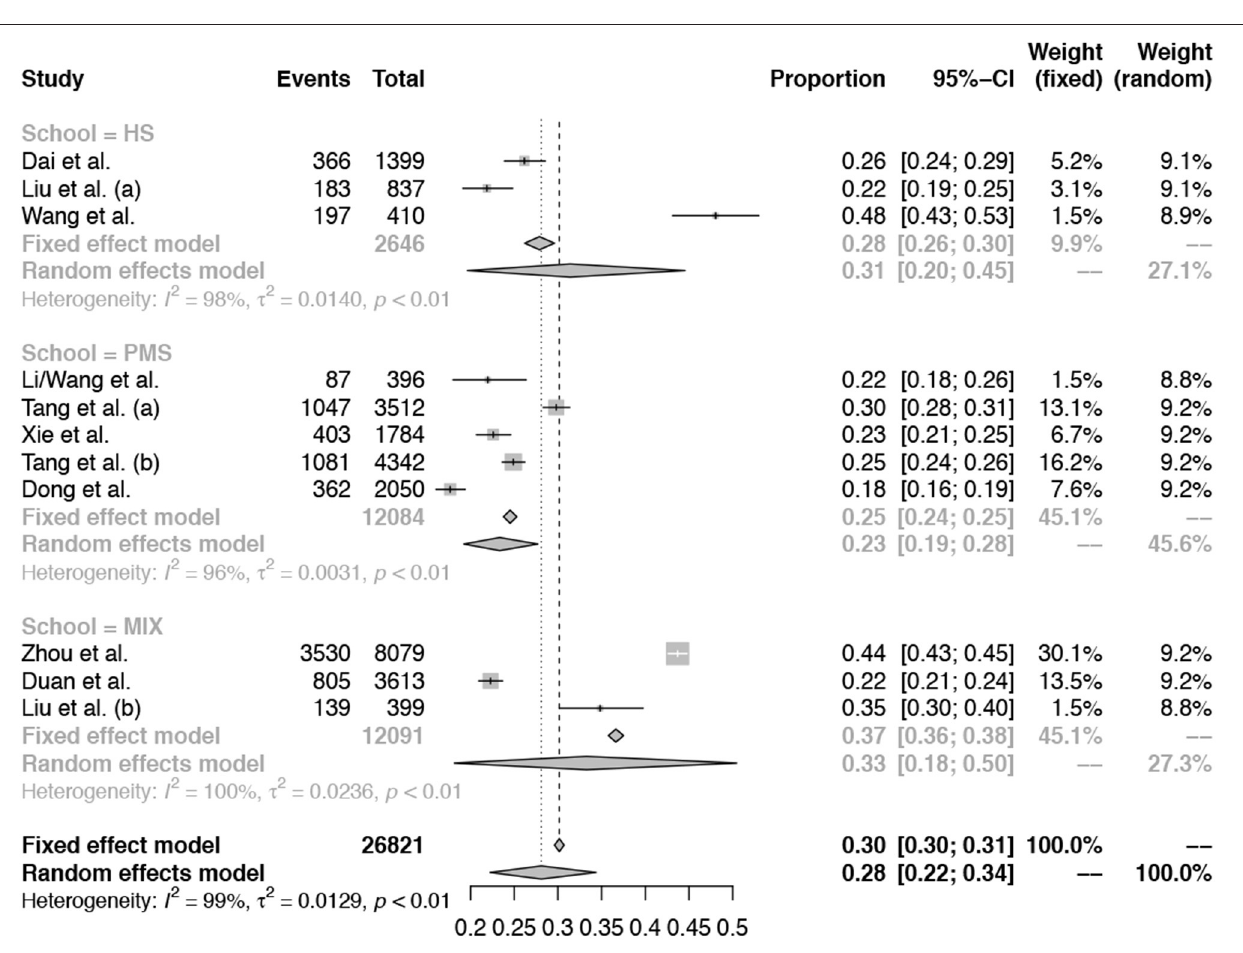
FIGURE 4 | Subgroup analysis by different “age groups” (primary and middle school vs. high